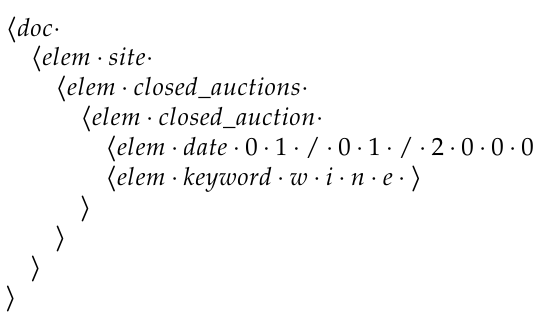
Figure 3. The corresponding nested word. Figure 2. An X ML document.